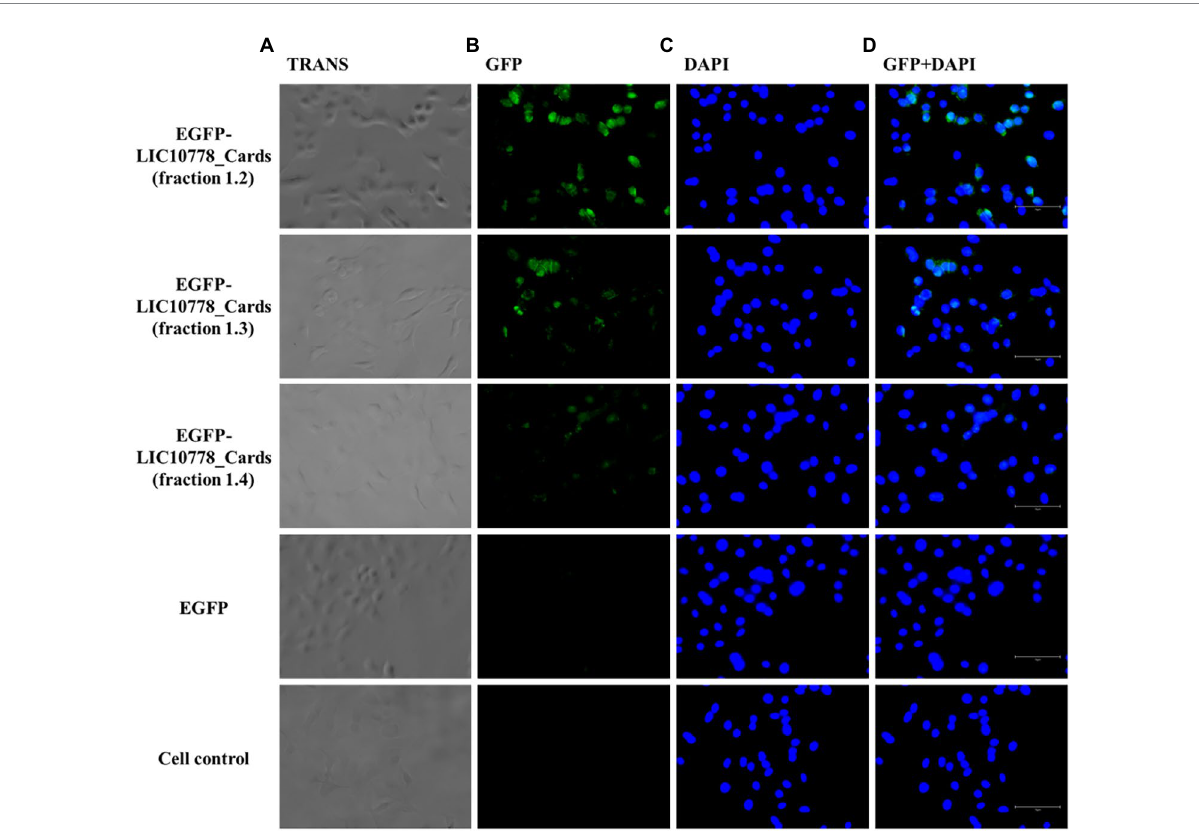
FIGURE 8 EGFP-LIC10778_Cards binding to A549 cells. Purified samples of EGFP-LIC10778 fused protein were incubated with A549 cells, previously cultured for 5 h in serum-free media. Following 2 h incubation with fluorescent proteins, including recombinant EGFP as negative control, cells were washed, fixed in 4% PFA, and incubated with DAPI for nuclear staining. Resulting fluorescence was observed under a fluorescence microscope (EVOS M5000, Thermo Fisher Scientific), considering available filter TRANS (transmitted light; A) , GFP (B), and DAPI (C) , and image magnification to 400×. In (D) , overlap of the same images from GFP and DAPI filters are represented, and white bars on the bottom right of each image represent 75 μ m in size. Cell control represents non-treated cells. Results were obtained from two independent